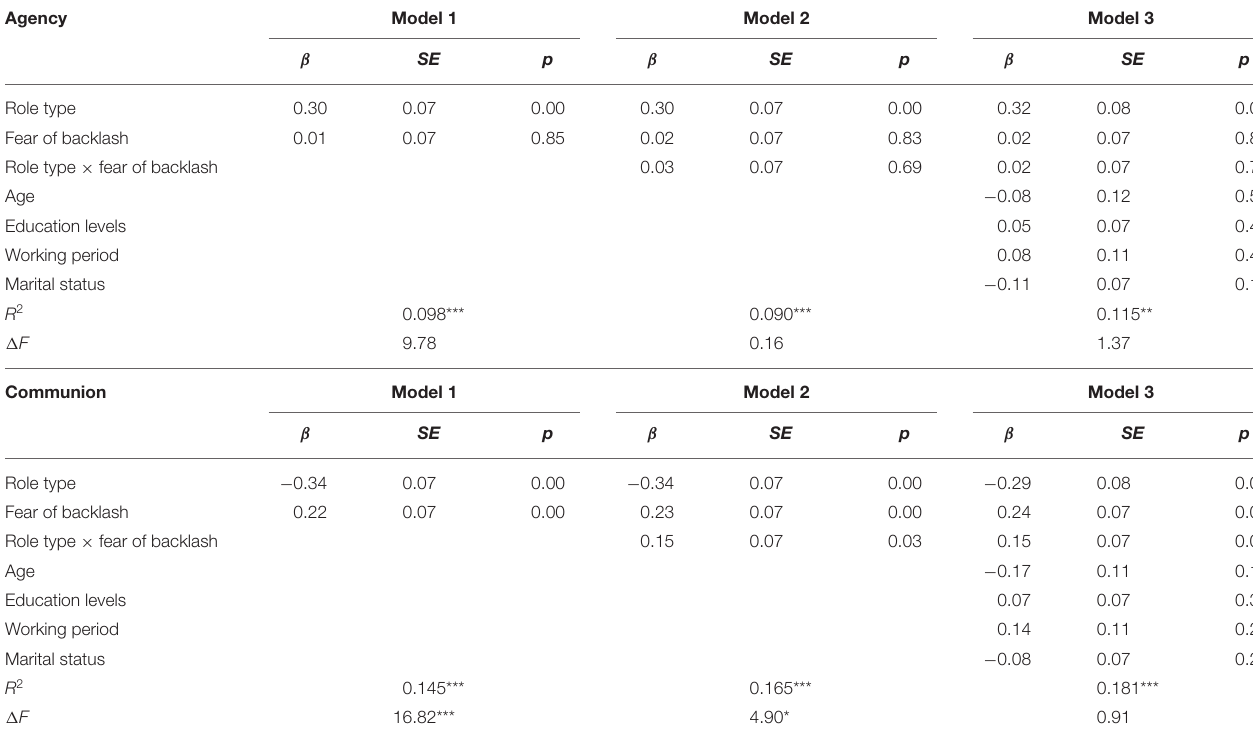
TABLE 5 | Hierarchical regression analyses for the moderation effect of fear of backlash on the relationship between role type of women and self-reported agency and communion in Study 3 (controlling demographic variables as covariates).